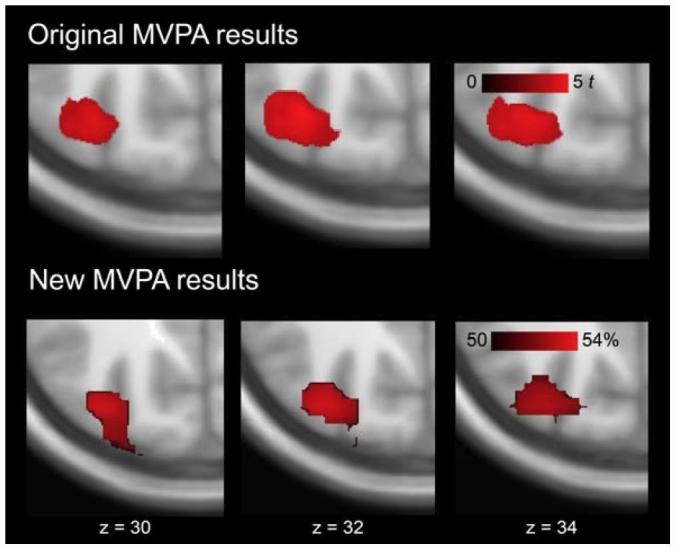
Multi-voxel representations of schema components within left AG.The image shows magnified, horizontal cut-outs at the level of AG. Data represents significant discrimination of rule-based associations. Upper row: original MVPA results as reported in the manuscript (Results, Multi-voxel representations of schema components). Effects were tested for significance using cluster-inference with a cluster-defining threshold of P < 0.001 and a cluster-probability of P < 0.05 family-wise error (FWE) corrected for multiple comparisons (Table 3). Lower row: new MVPA results using the permutation framework. No cluster correction was applied. Both approaches yielded representations of rule-based associations within left AG.